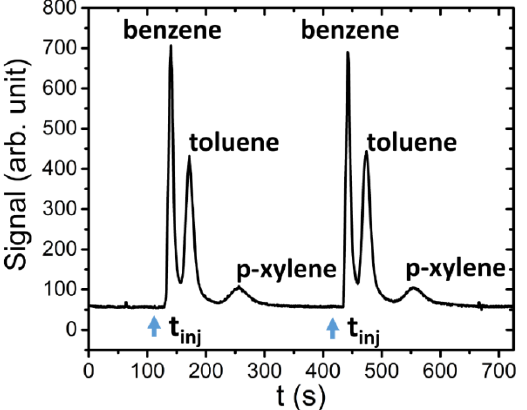
Figure 9. Example of two repetitions of a mixture injection (1.7 µg of benzene, 1.2 µg of toluene and 1.5 µg of p-xylene).